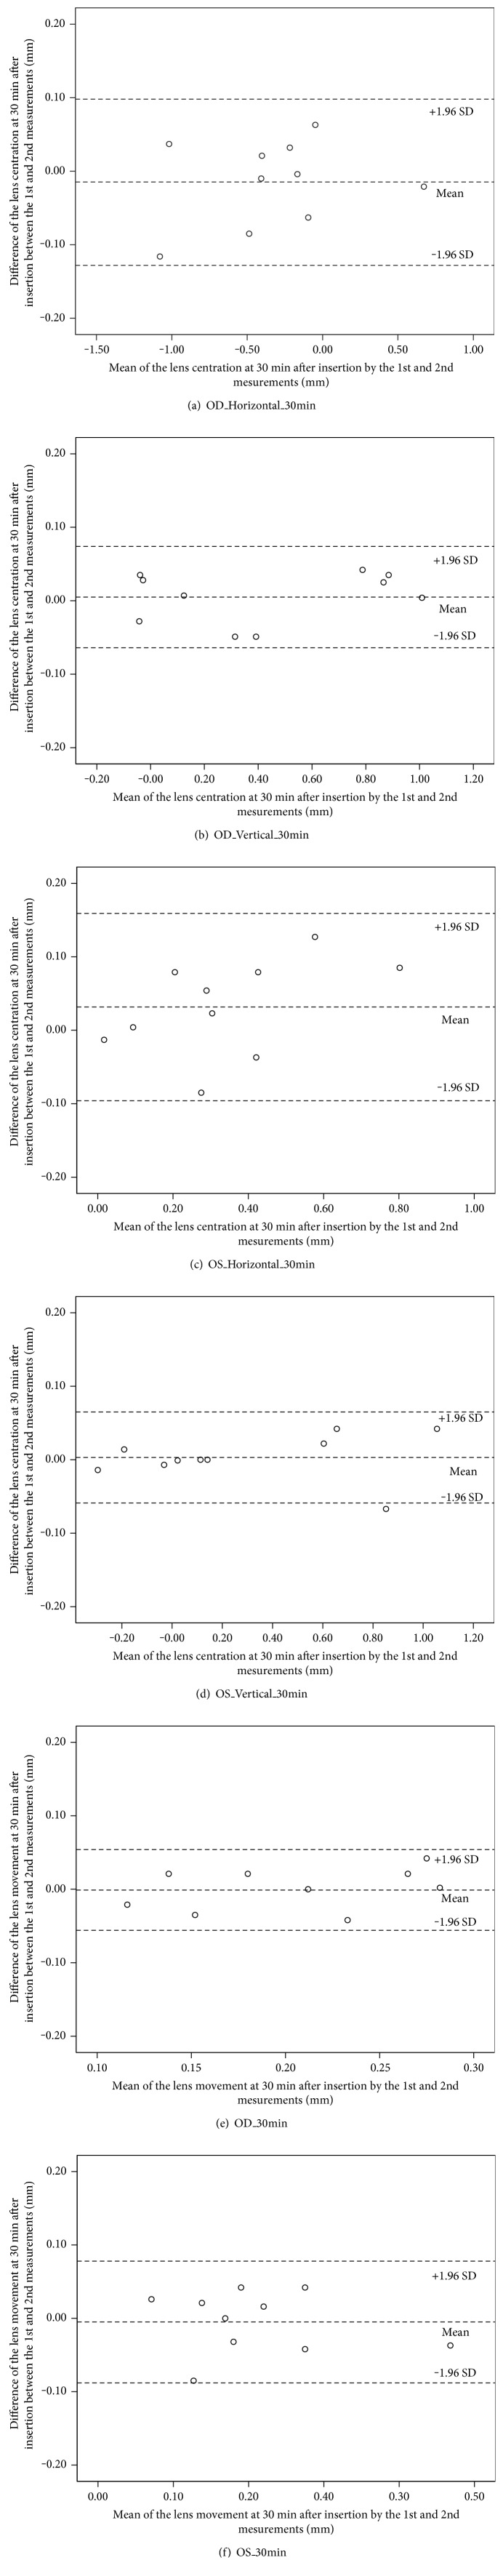
Bland-Altman plots of the differences between two measurements of the lens centration and movement at 30 min after insertion. The mean differences of the variables between two repeated measurements for lens centration (a)–(d) at both meridians and the blink induced (e)-(f). The mean differences in the values between the two measurements were around zero. OD: the right eye; OS: the left eye.